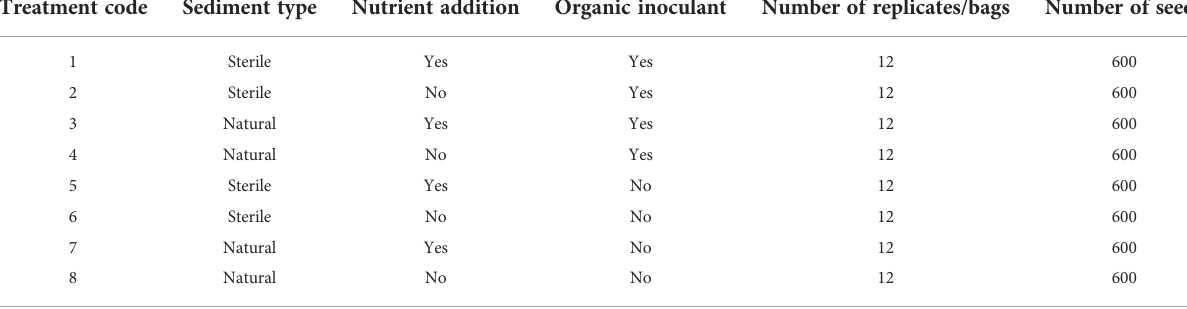
TABLE 1 Treatment designs used in experimental sites in Dale,